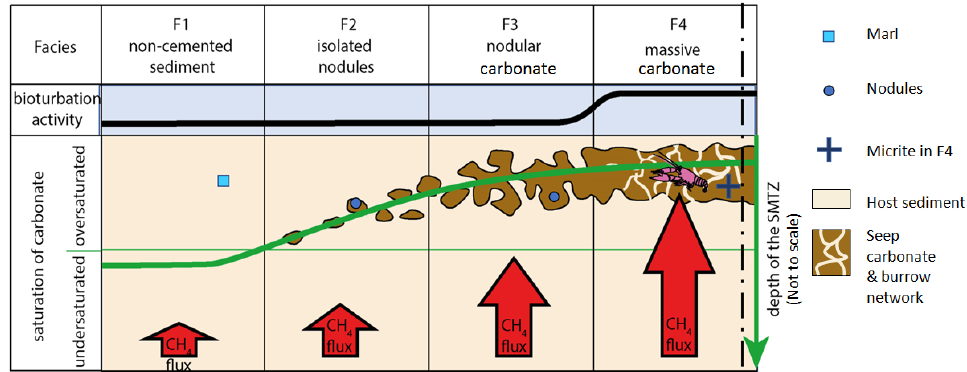
Figure 14. Change in depth of the sulfate–methane transition zone (SMTZ) and seep carbonates (brown) from host sediment towards the pseudobioherm; the vertical dashed line marks the axis of the pseudobioherm; geometric symbols refer to the isotope data shown in Fig. 13a; the decapod crustacean symbolizes the burrowers responsible for the gas-focusing burrow network. (Not to